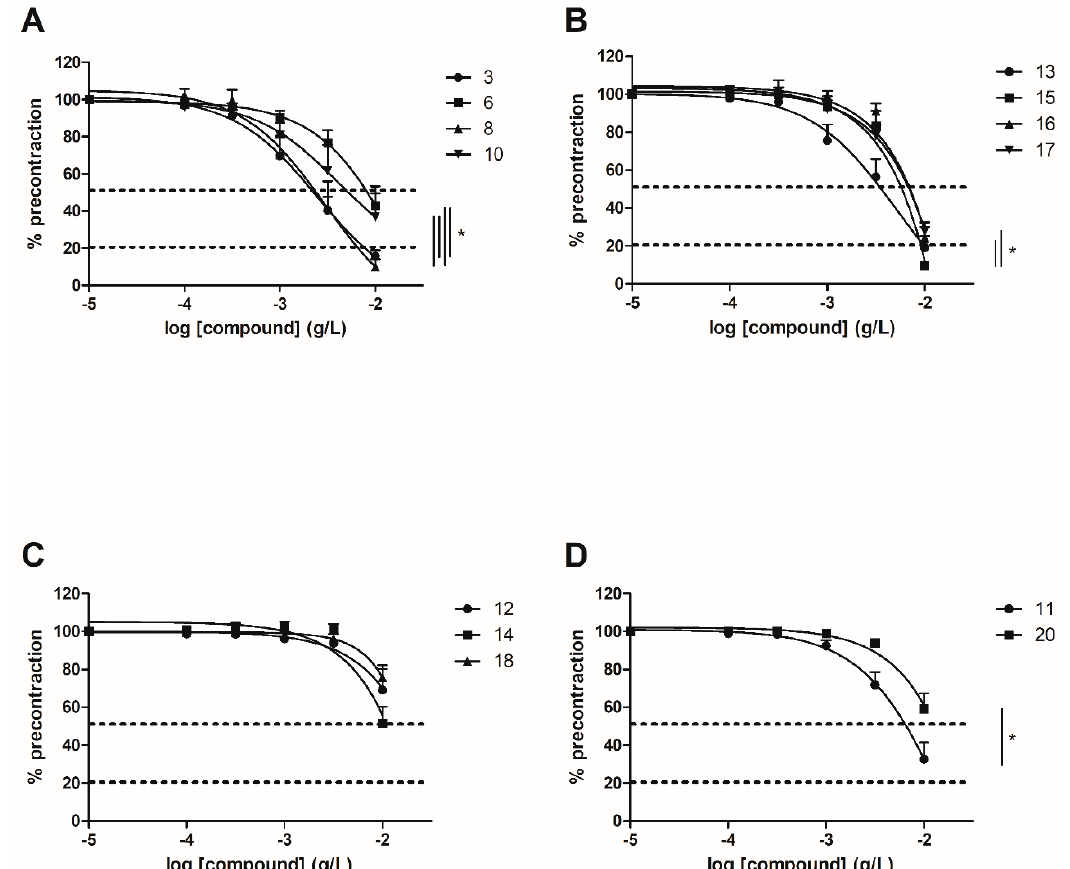
Figure 1. Concentration-response curves for the vasorelaxation effect on WT mice thoracic aorta of synthetic polyoxygenated chalcones. A : vasorelaxation effect of chalcones with R 2’ = R 4’ = OH and R 6’ = H or OH; B : vasorelaxation effect of chalcones with R 2’ = R 4’ = OCH 3 and R 6’ = H or OCH 3 ; C : vasorelaxation effect of chalcones with R 2’ = OH, R 4’ = OCH 3 and R 6’ = H or OCH 3 ; D : vasorelaxation effect of chalcones with R 2’ = R 4’ = OCH 3 and R 6’ = H. Mice were ovariectomized 7 days before the experiment. Vessels were pre-contracted with U46619, phenylephrine, and serotonin, at 80 % of their maximal response. The presence of functional endothelium was assessed by determining the ability of acetylcholine (10 µM) to induce more than 50% relaxation of pre-contracted rings. Results are expressed in percentage of precontraction (y-axis) following the concentration (x-axis). Compounds 3 , 8 , 13 and 15 induced higher vasorelaxation, over 80%. Compounds 6 , 10 , 11 , 16 and 17 induced an average vasorelaxation between 50% to 80%. Compounds 12 , 14 , 18 and 20 exerted a low vasorelaxation effect below 50%. N = 4–7, * p < 0.05, ** p < 0.01 (Mann-Whitney). Table 2. Summary of the potency and efficacy of chalcones.